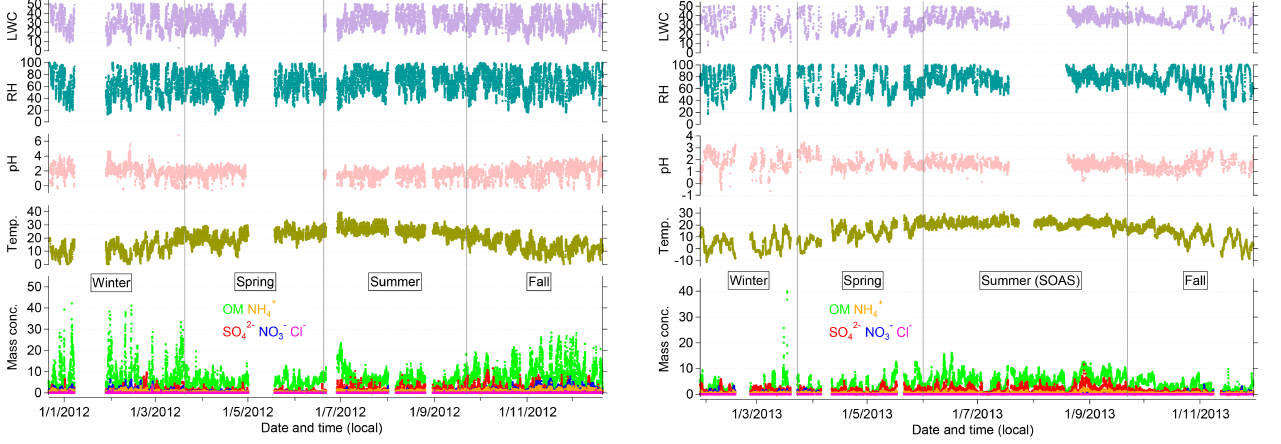
Figure 2. Annual temporal variations of OA and inorganic species (µgm − 3 ) measured at the Look Rock (LRK) site, Great Smoky Mountains, Tennessee, in 2013. Included in the plots are ambi- ent temperature and RH (%) measured by Tennessee Valley Au- thority (TVA), as well as pH and LWC (molL − 1 ) estimated by